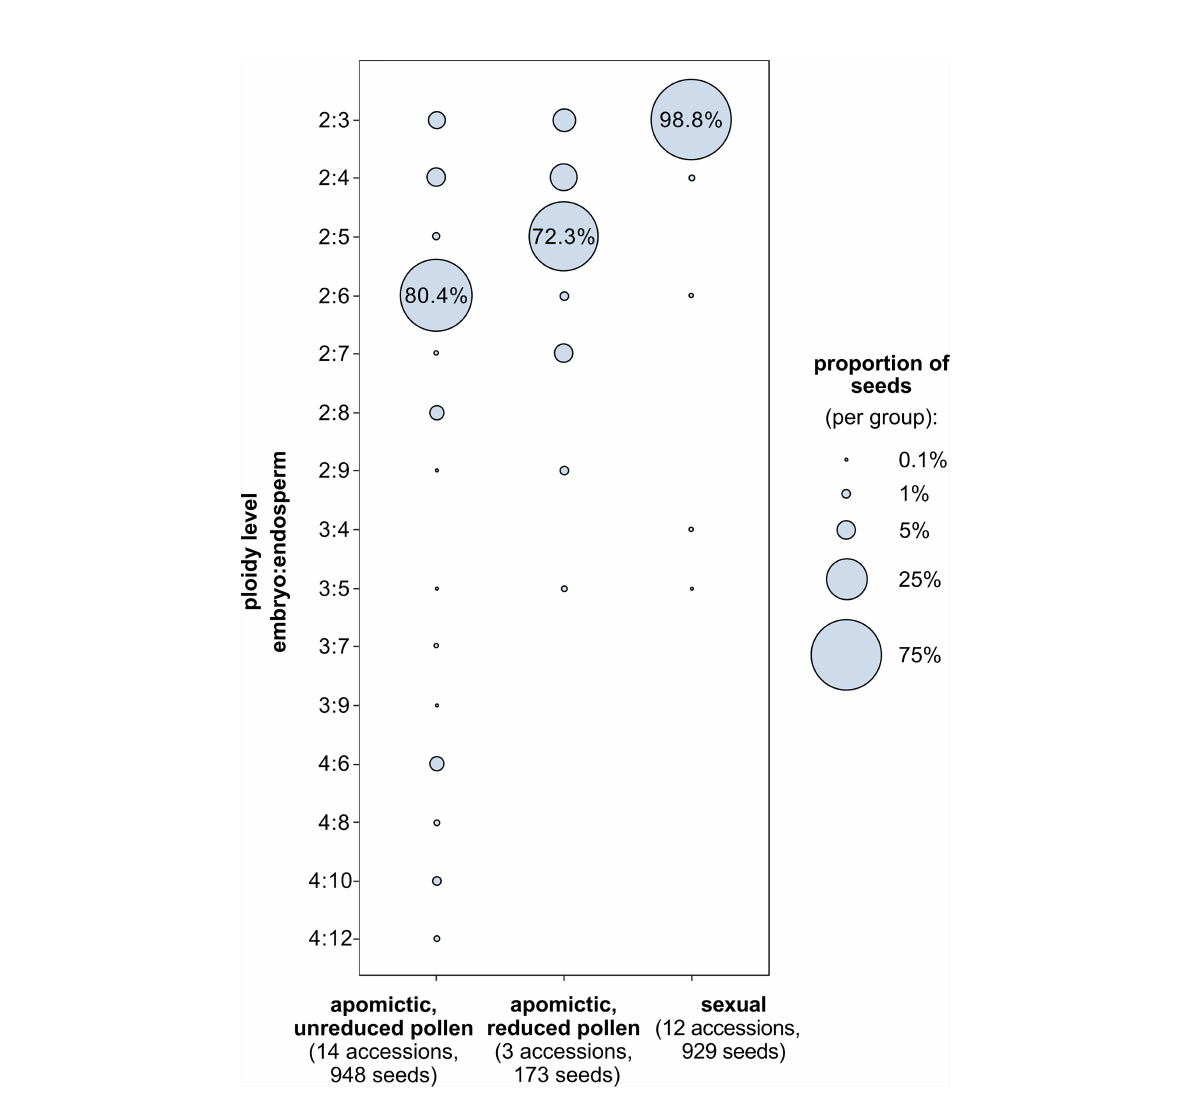
FIGURE 4 Proportions of seed types characterized by embryo and endosperm ploidy combinations (y-axis) among sexual and diploid apomictic Boechera . Ploidy level denotes the number of chromosome sets (x) in the embryo and endosperm. Among apomictic accessions there are two groups: those that produce unreduced (2x) and reduced (1x) pollen ( “ balanced ” and “ unbalanced ” sensu Mau et al., 2021), which produce seeds with predominantly hexaploid (6x) and pentaploid (5x) endosperm